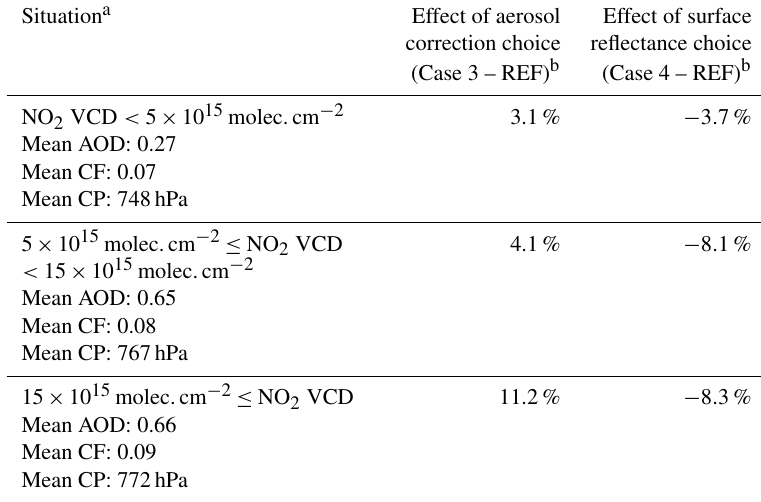
Table 3. Effects of choices of aerosols and surface reflectance inconsistent with using the CP data from FRESCO-S in July